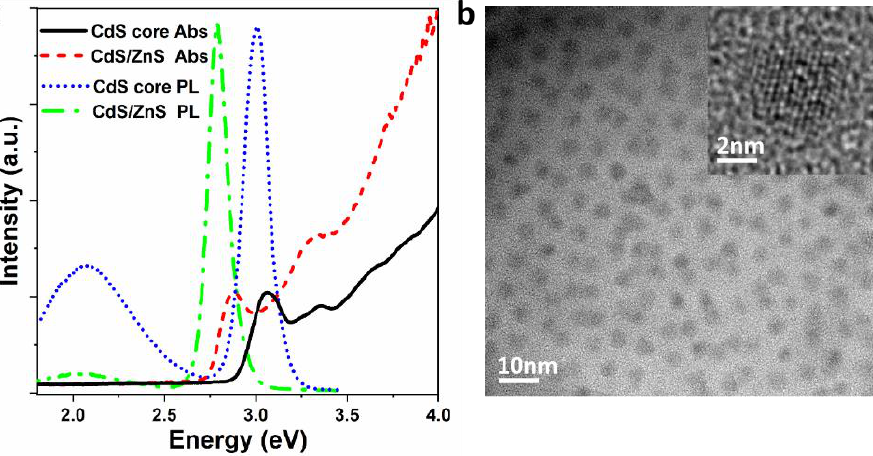
Figure 1. ( a ) Absorption and photoluminescence (PL) spectra of CdS core QDs (black solid line and blue dotted line) and CdS/ZnS core/shell QDs (red short dash line and green short dash dot line). ( b ) A typical transmission electron microscopy (TEM) image of CdS/ZnS core/shell QDs. Inset is corresponding high resolution TEM (HRTEM) image of the QDs.